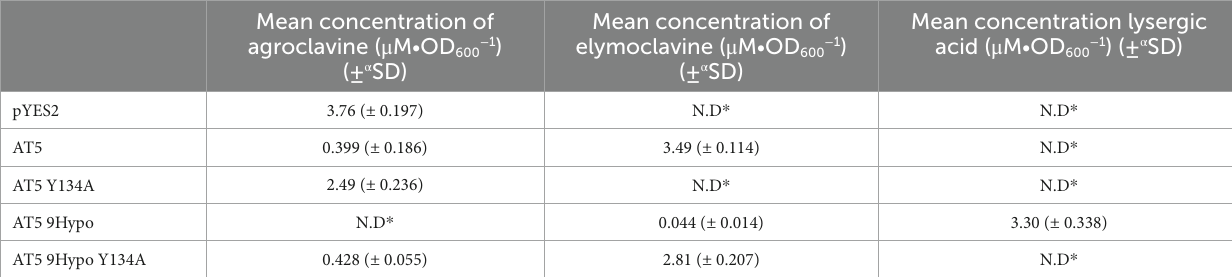
TABLE 3 Summary of the activity of AT5 and AT5 9Hypo cloA Y134A mutants in the presence of